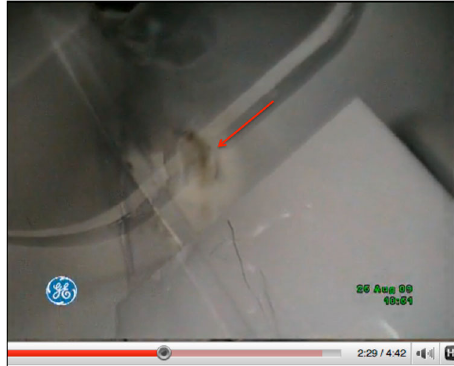
FIG. 3. Photograph of the top surface of the vacuum chamber roughly above the injection foil. The red arrow indicates the location of the edge of the black mark on the chamber surface (just left of center in image).